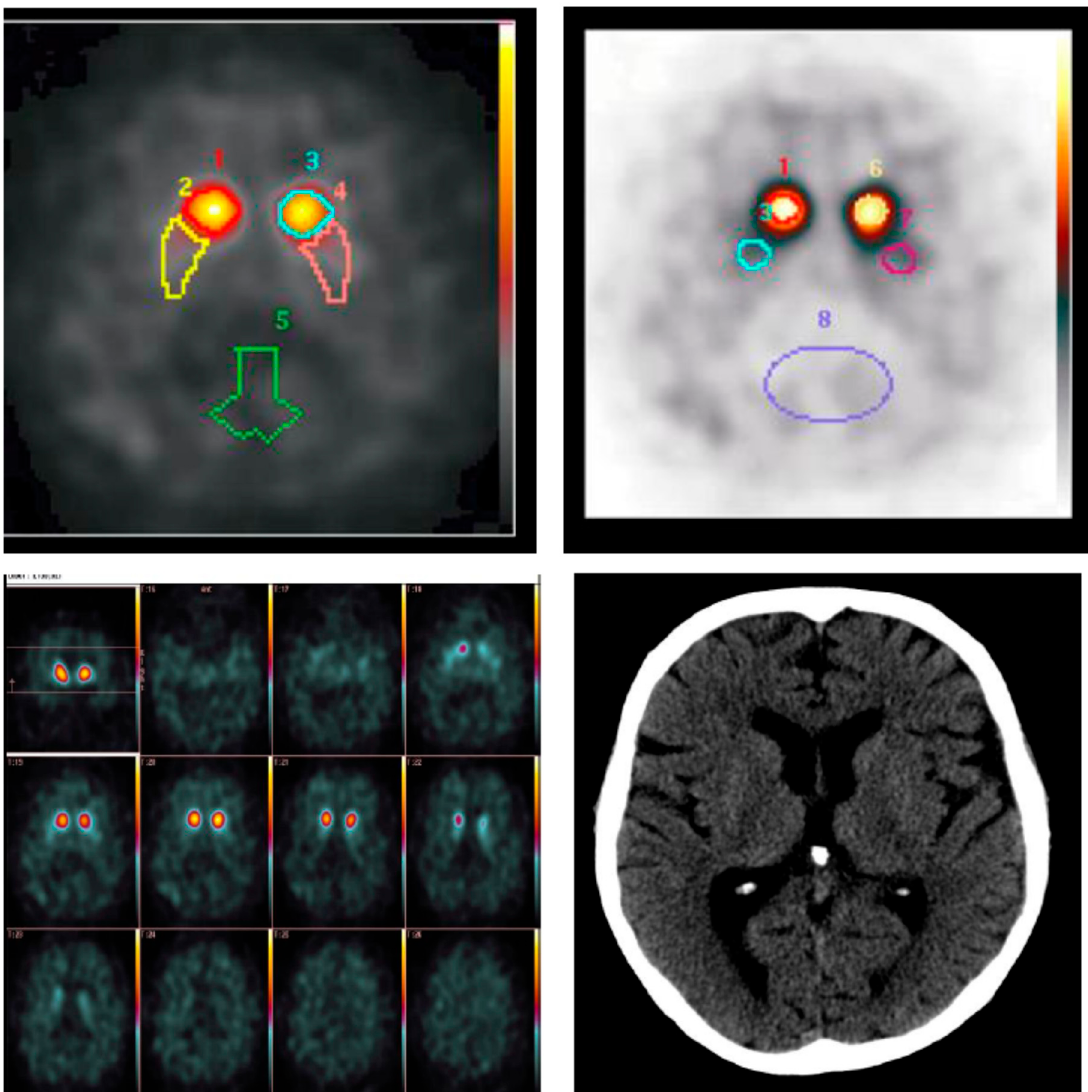
Figure 1. Beta-CIT-Spect and non-contrast computed tomography imaging excerpts from the time of diagnosis.